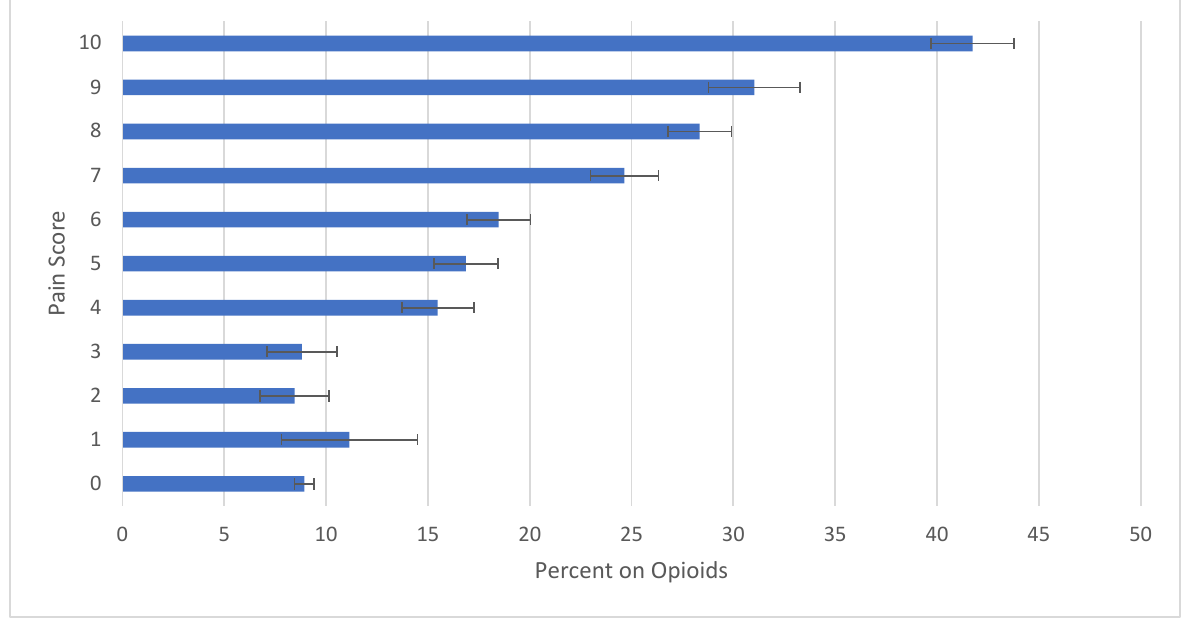
Figure 1. Proportion of Overall Opioid Prescribing per Pain Score Reported in US EDs from 2008 to 2017. Calculated using a 95% confidence interval.